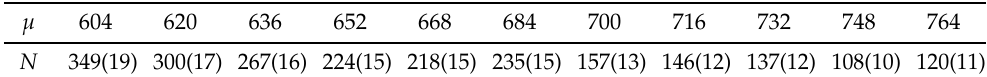
Table 3. The ATLAS number of N = N ( γγ ) events, in bins of 16 GeV and for luminosity 139 fb − 1 , for the range of invariant mass µ = µ ( γγ ) = 600 ÷ 770 GeV. These values were extracted from Figure 3 of [31] because the relevant numbers are not reported in the companion HEPData